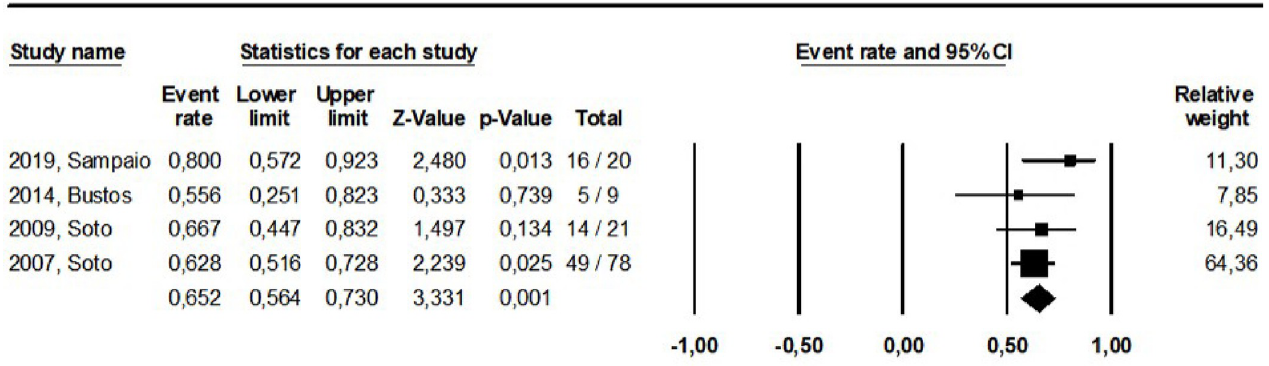
Fig 6. Pooled cure rate including all patients treated for ML with miltefosine in the reviewed studies.